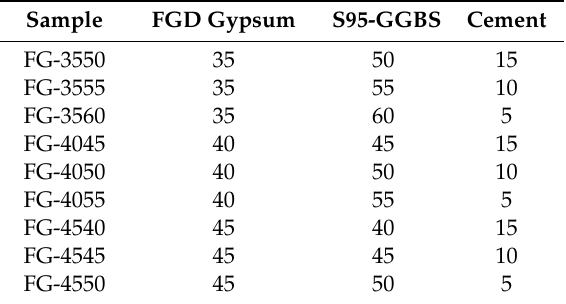
Table 2. Mix proportion of mortar samples (wt.%).